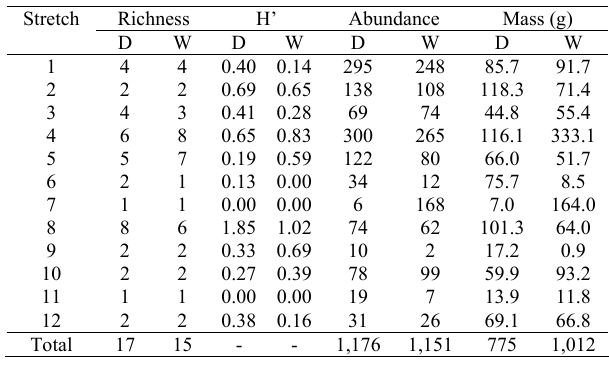
Table 3. Species richness, Shannon diversity (H’), abundance and mass of fish sampled in dry (D) and wet (W) seasons in stream stretches of the APA Gama and Cabeça de Veado.